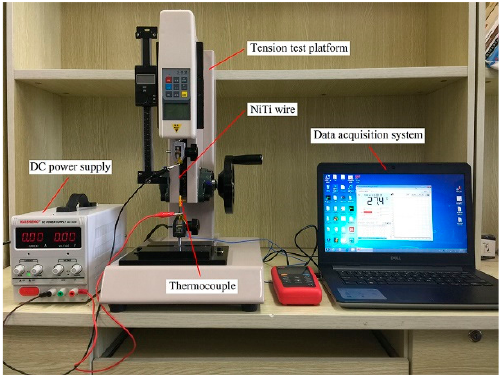
Figure 2. Experimental setup of the heating response rate tests.